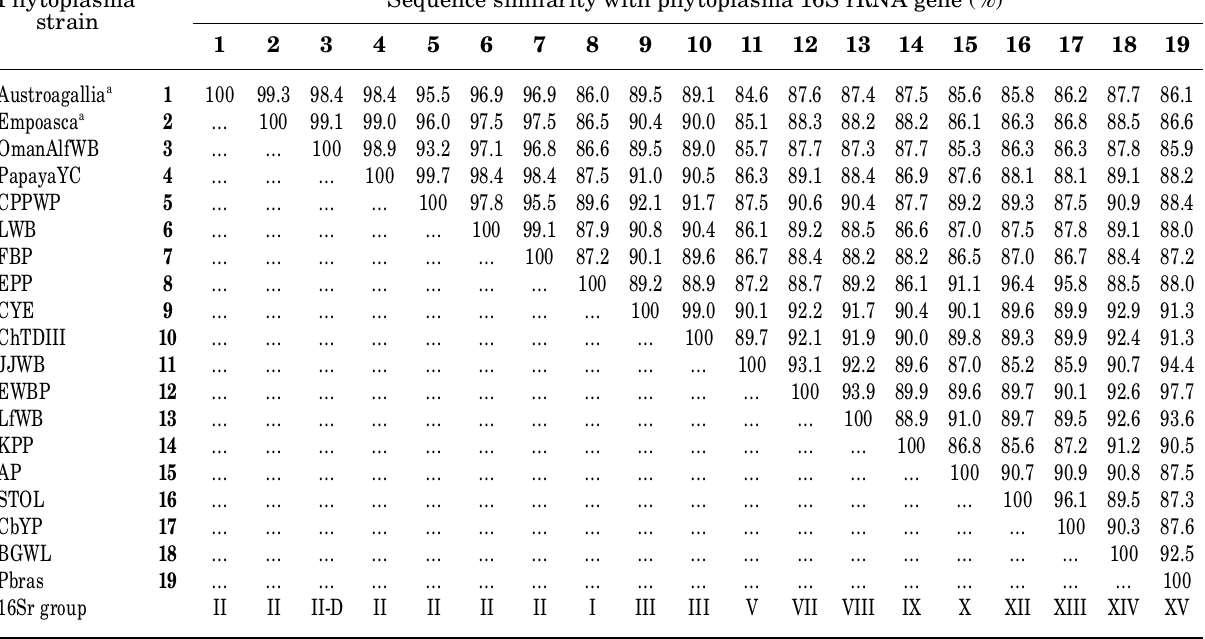
Table 2. Analysis of sequence similarities among 16S rRNA gene belonging to selected 16SrII groups and phytoplas- mas from other